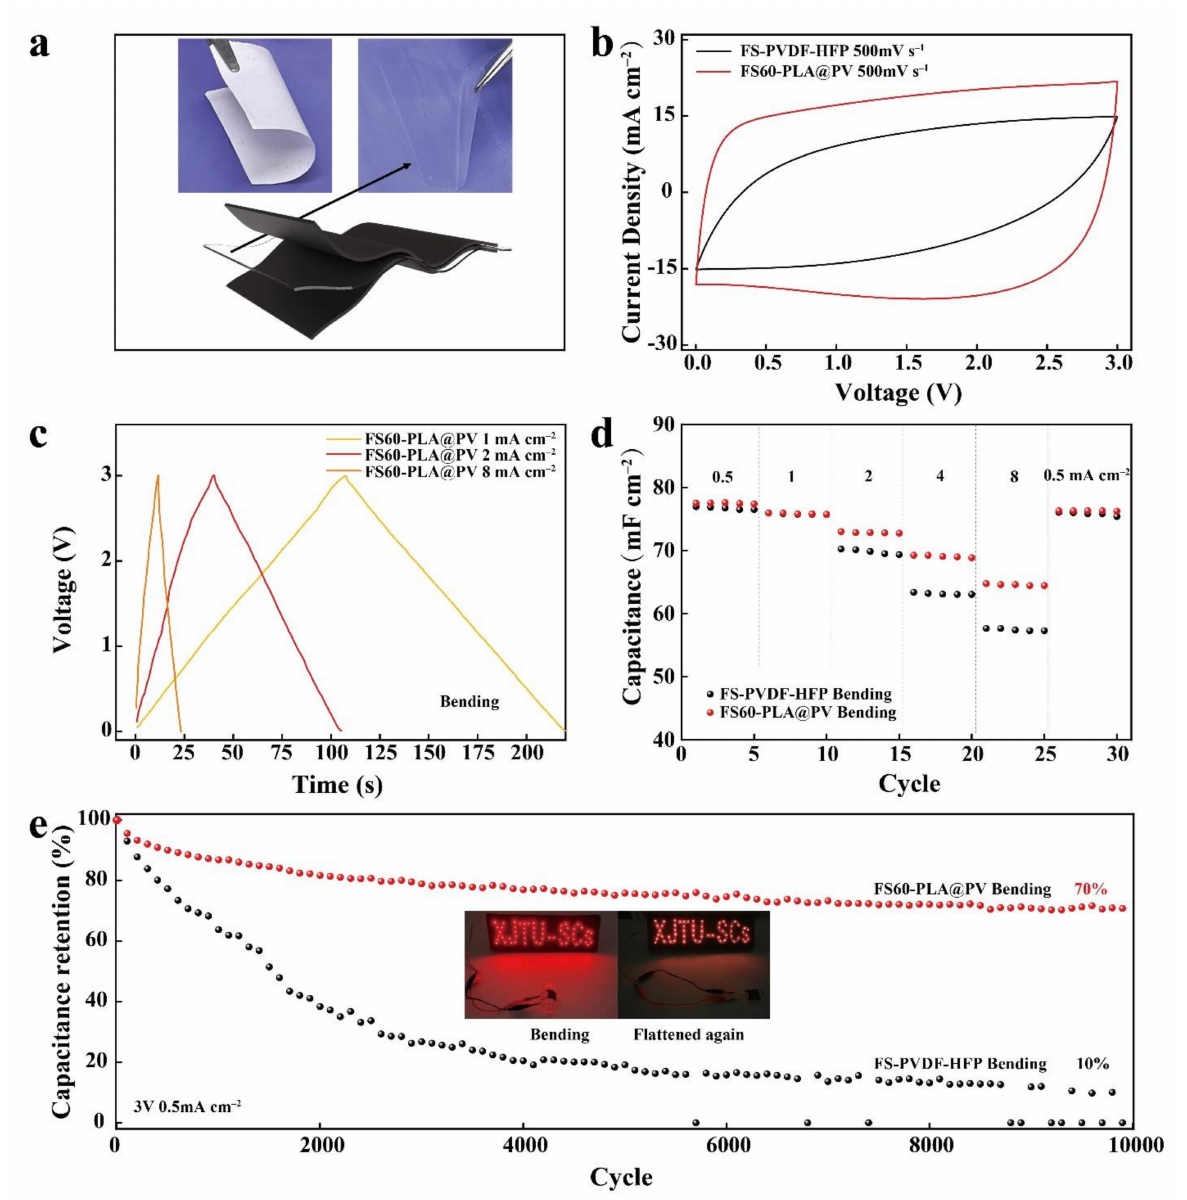
Figure 6. Flexible supercapacitor: ( a ) Digital images of flexible membrane before and after LE immersion. ( b ) Comparison of CV curves at high scan rates of FS. ( c ) Galvanostatic charge/discharge profiles. ( d ) Specific capacitance with increasing current densities (3 V). ( e ) Cycling performance at 0.5 mA cm − 2 (3